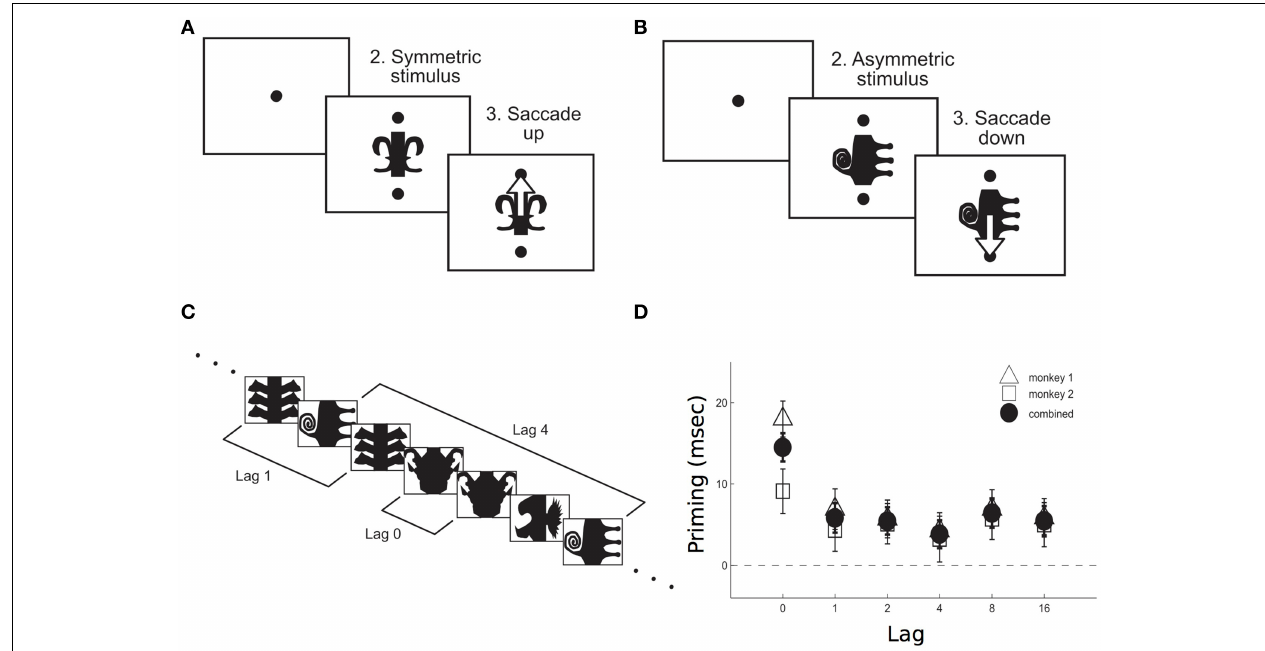
FIGURE 1 | Priming effect as measured in monkeys performing a symmetry decision task. After a fixation period (200ms), either a symmetric (A) or an asymmetric (B) stimulus appeared on the screen, together with two cues. Monkeys were required to make a saccade upwards/downwards in response to a symmetric/antisymmetric stimulus. Priming was measured for